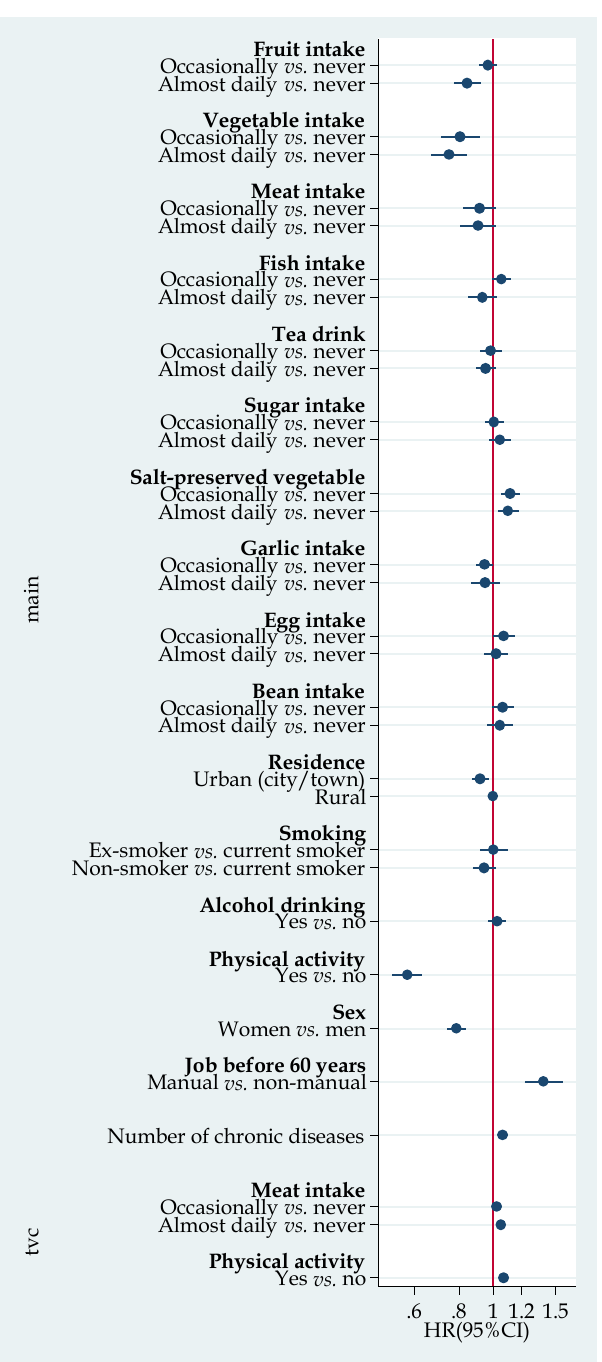
Figure 1. Hazard ratio (HR) (95% CI (Confidence Interval)) for all-cause mortality according to lifestyle factors. Model adjusted for age, and all the variables listed in the figure. The time-varying covariate (TVC) section provided results on the interaction between meat intake, physical activity and time (years). TVC represents covariate × time interaction. HRs for daily meat × time and physical activity × time was 1.05 (95% CI 1.02–1.08) and 1.07 (95% CI 1.05–1.09), respectively.